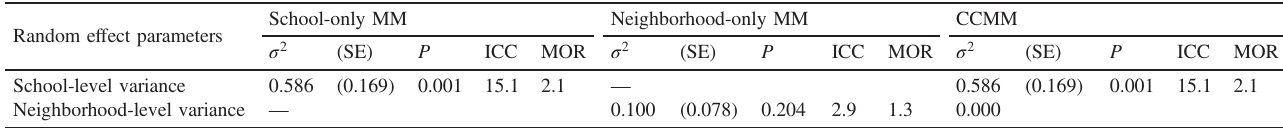
Table 2. Measures of variations in current alcohol use base on multilevel models without any explanatory variables ( n = 3,291) Random e ff ect